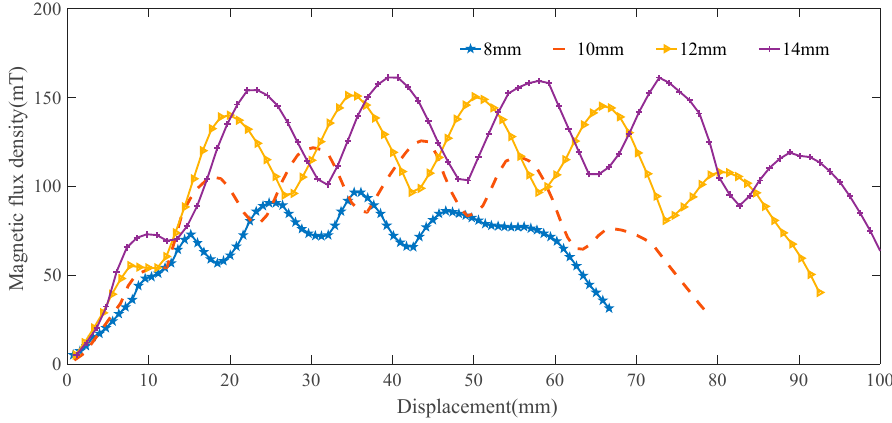
Figure 6. Effect of the magnetic ring axial height on the magnetic flux density.